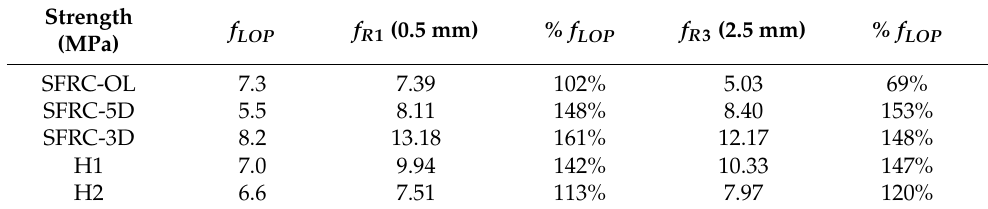
Table 4. Residual strength of the concrete formulation in relation with the requirements set by [22].